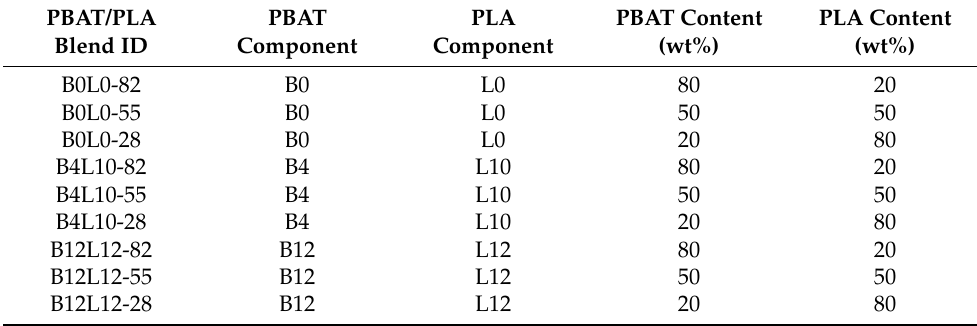
Table 2. Formulation of solution–blended